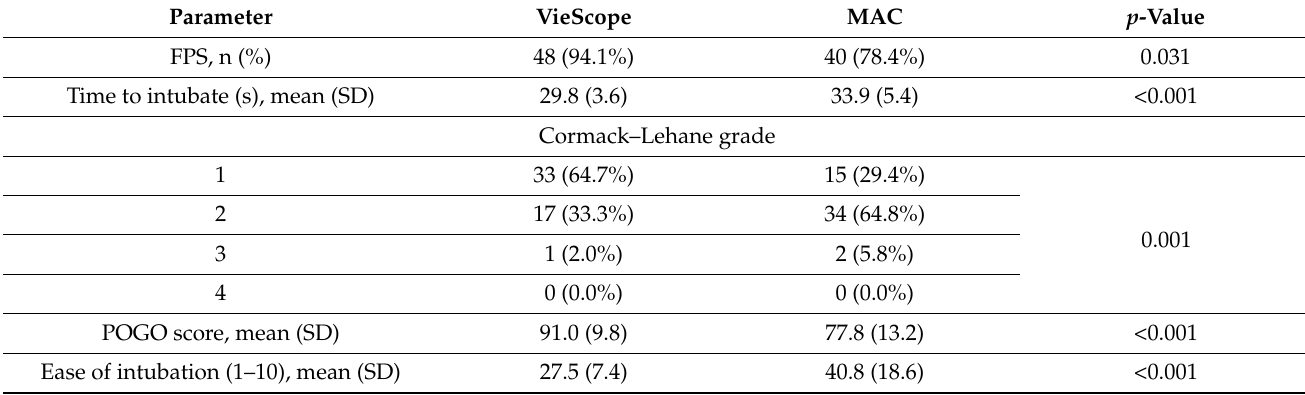
Table 2. Intubation with personal protective equipment for aerosol-generating procedures (PPE- AGP)